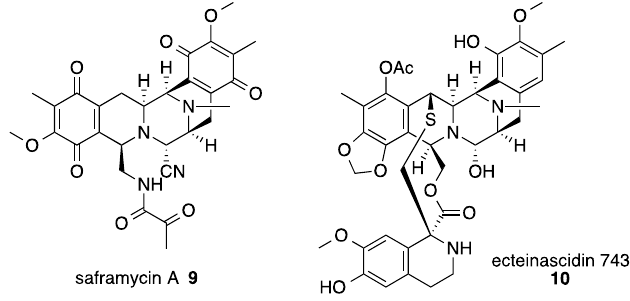
Figure 7. Chemical structures of tetrahydroisoquinoline alkaloids, saframycin A 9 [21] and ecteinascidin 743 10 [24].